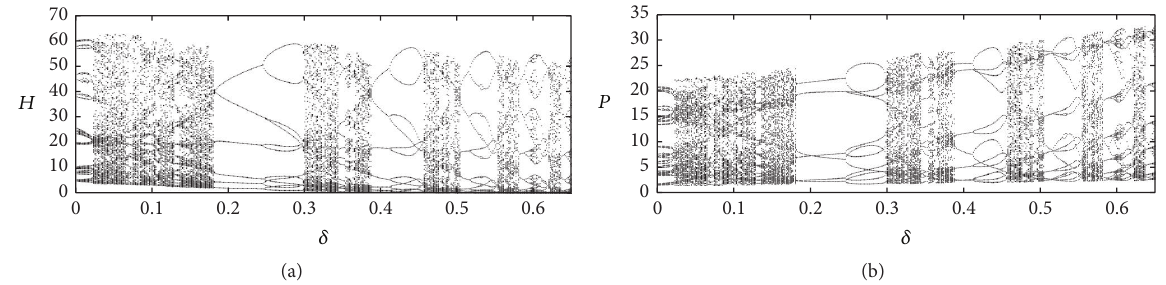
Figure 10: Bifurcation diagram with respect to parameter 𝜃 . The parameter values are as follows: 𝑇 = 10 , 𝑇 ℎ = 0.5 , 𝐾 = 50 , 𝛾 = 1 , 𝛼 = 0.015 , 𝜃 = 1 , 𝑞 = 0.2 , and 𝑟 = 2.6